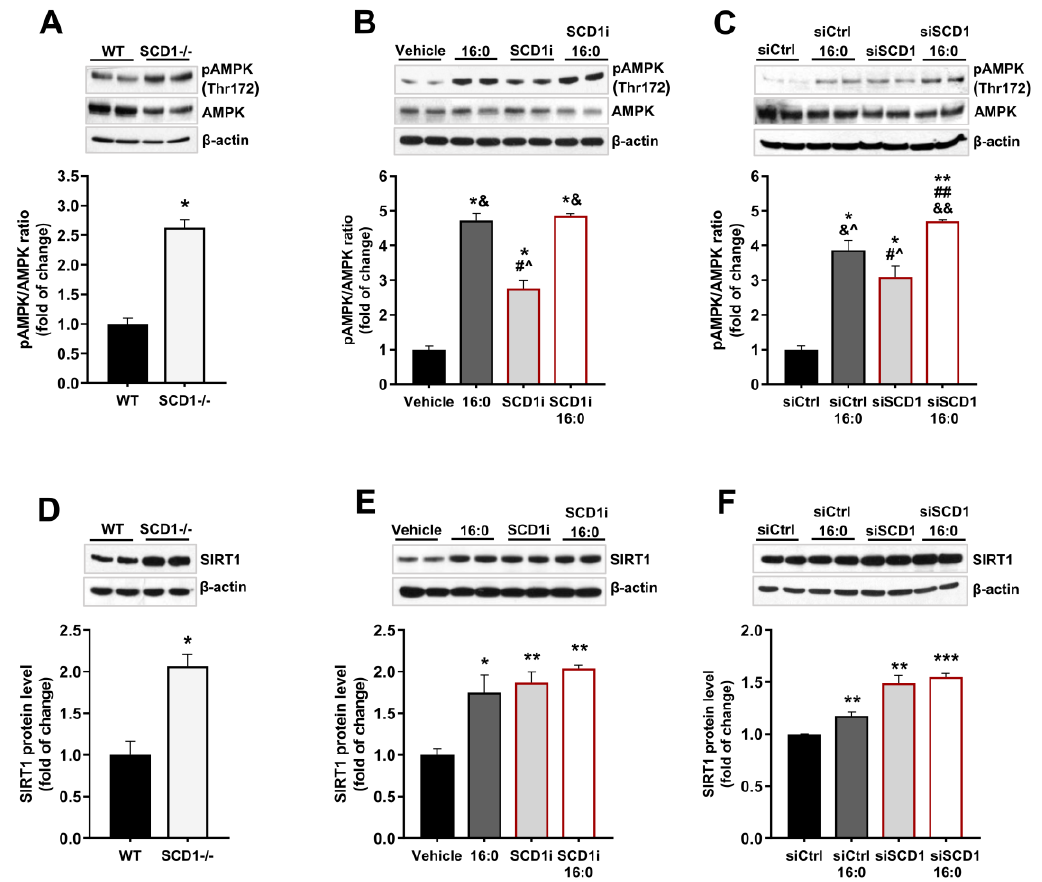
Figure 4. SCD1 regulates adenosine monophosphate-activated protein kinase (AMPK) and NAD-dependent deacetylase sirtuin-1 (SIRT1) in pancreatic islets and INS-1E cells. ( A , D ) Western blot analysis of AMPK phosphorylation at Thr172 ( A ) and the level of SIRT1 protein ( D ) in pancreatic islets from WT and SCD1 − / − mice. n = 6. * p < 0.05, vs. WT. ( B , C , E , F ) AMPK phosphorylation at Thr172